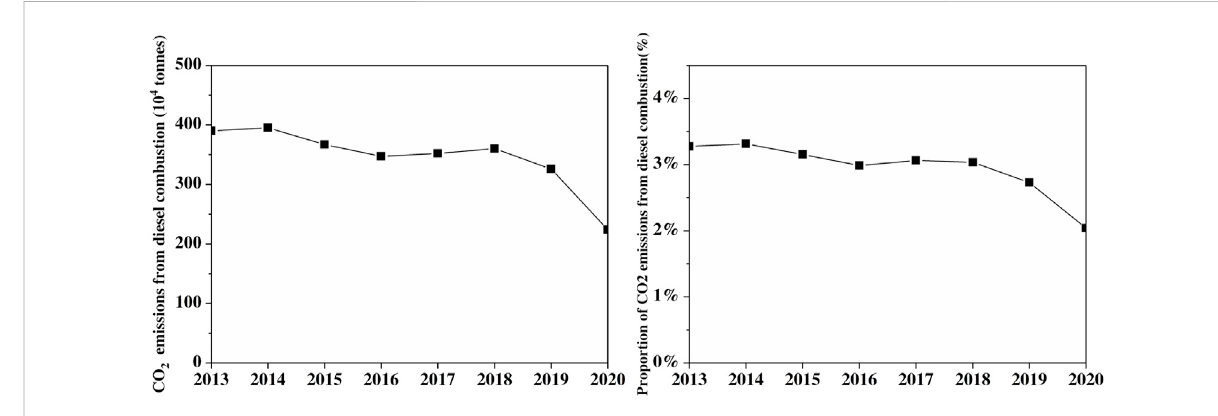
FIGURE 4 Changes in CO 2 emissions from diesel combustion and the proportion of CO 2 emissions from diesel combustion in Beijing.